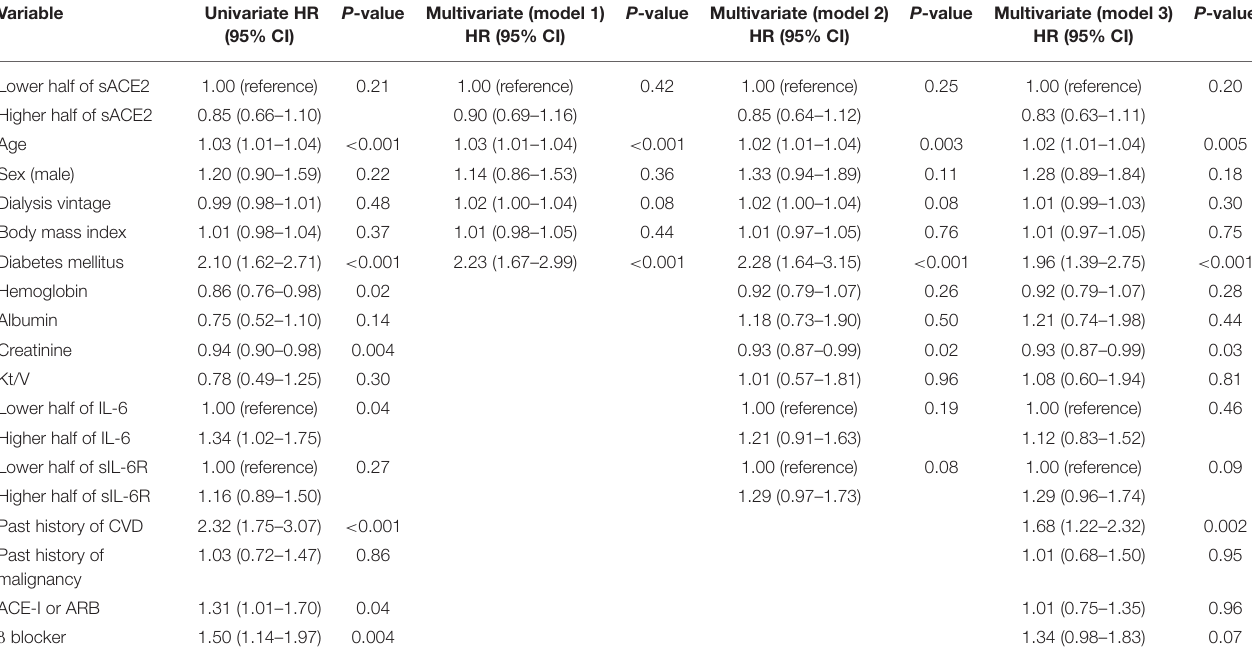
TABLE 4 | Univariate and multivariate Cox proportional hazard models of cardiovascular disease.